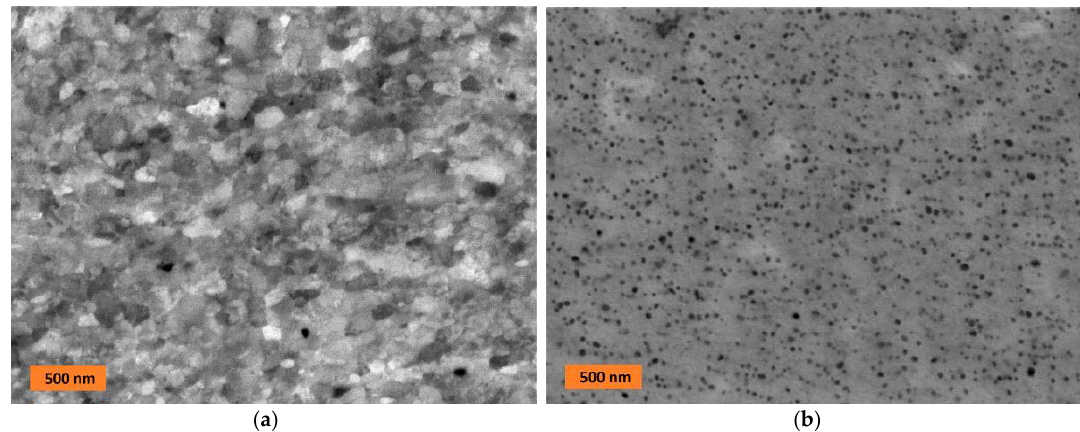
Figure 2. SEM micrograph (in backscattered electrons (BSE)) of ( a ) the typical ultra fine-grained microstructure of the new-generation oxide dispersion strengthened (ODS) alloy after hot rolling and ( b ) detail of the typical microstructure of nanooxide dispersion in large grains after secondary recrystallization.